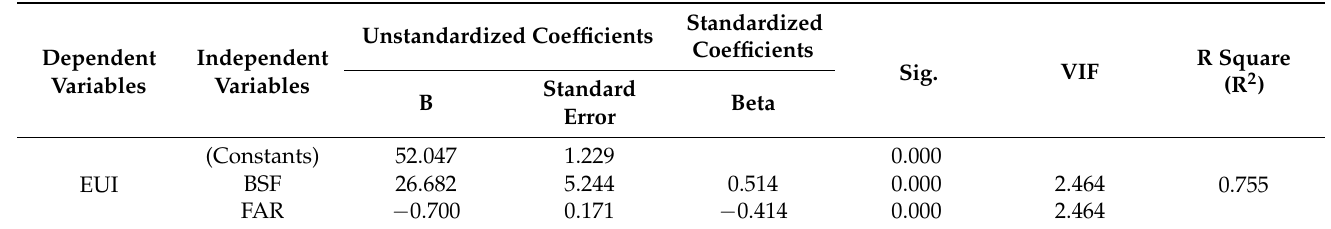
Table 5. Regression analysis